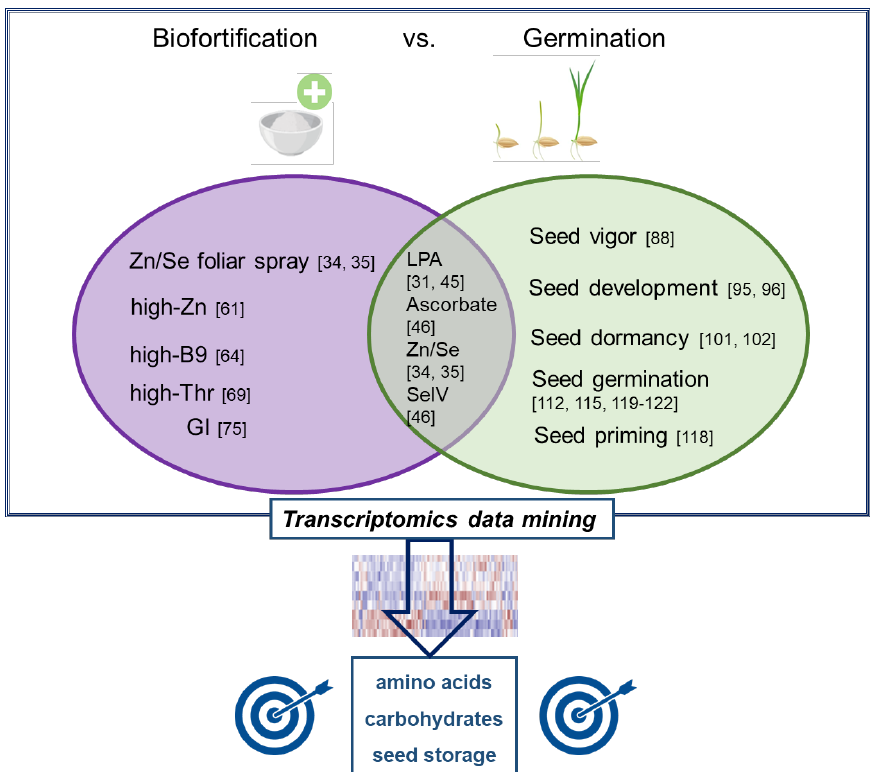
Figure 1. Schematic representation summarizing transcriptomics studies applied at the interface between rice biofortification (left) and seed germination (right). The overlapping region includes studies where germination aspects were investigated in biofortified rice. The blue square represents putative target pathways, mined from transcriptomics studes, that may result in trait pyramiding. References are indicated as numbers.